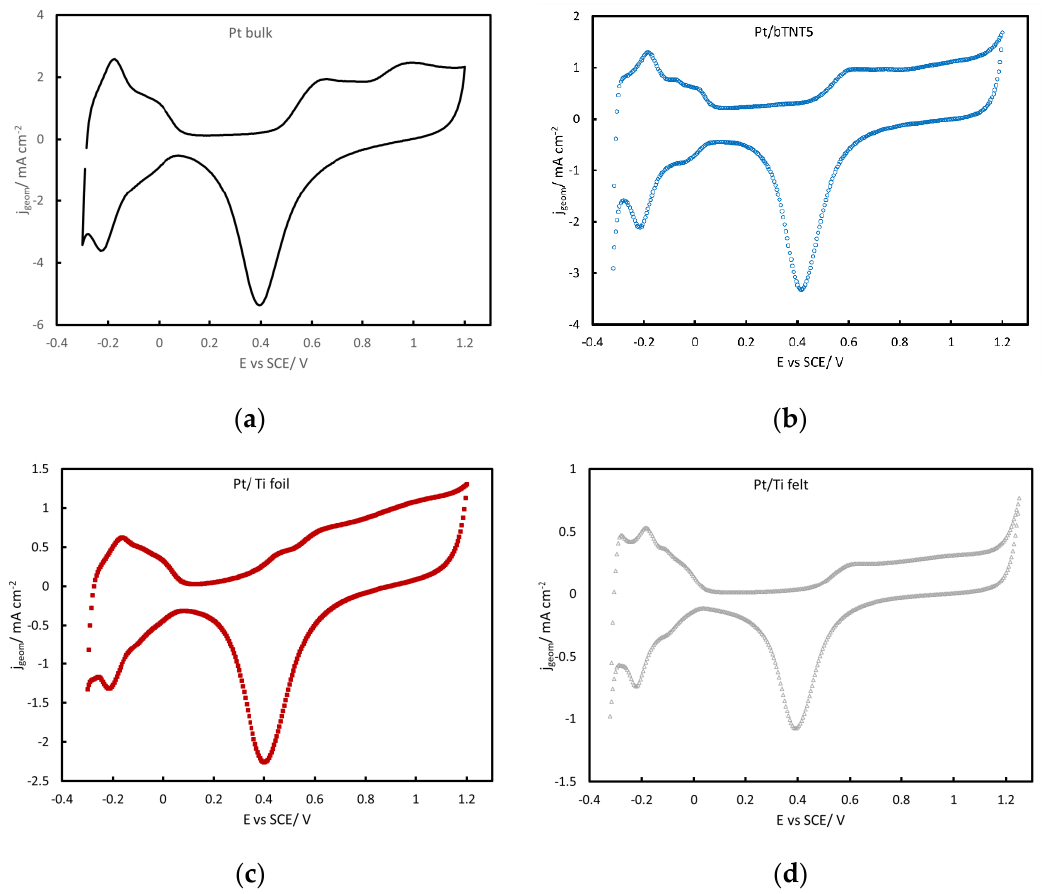
Figure 4. Cyclic voltammograms of ( a ) polycrystalline bulk Pt at a scan rate of 500 mV s -1 , ( b ) Pt/bTNT5 at 50 mV s −1 , ( c ) Pt/Ti foil at 50 mV s -1 and ( d ) Pt/Ti felt at 50 mV s -1 , in a N 2 -deaerated 0.1 M HClO 4 solution .